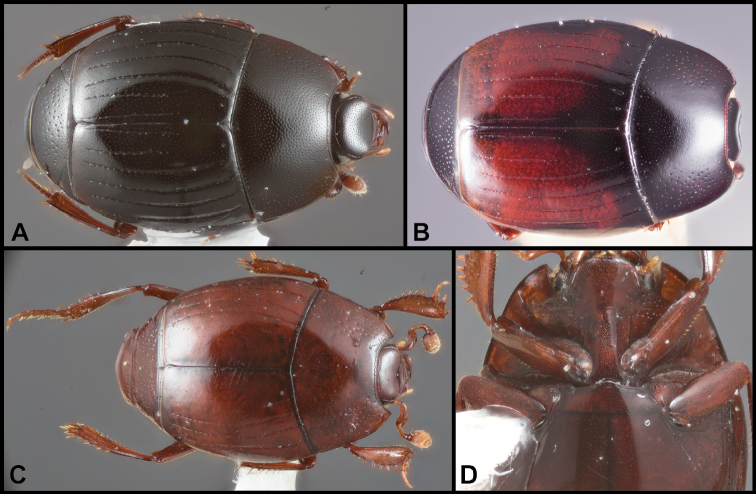
APhelistervernus (Say), dorsal habitus BPhelisterchilicola, dorsal habitus C–DPhelisterbruchi Bickhardt: C Dorsal habitus D Ventral view showing prosternal and meso- and metaventral striae.